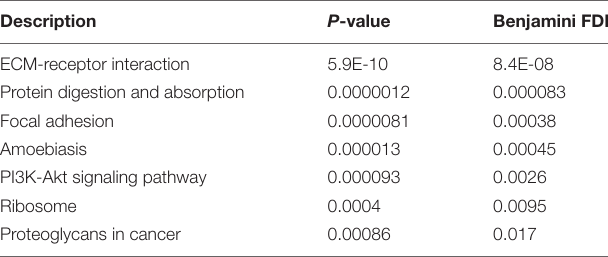
TABLE 6 | KEGG pathway enrichment